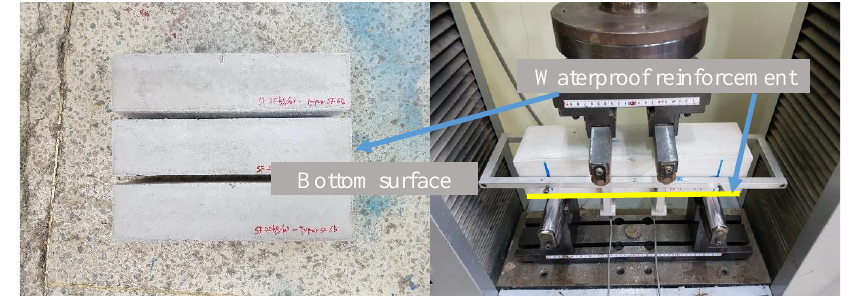
Figure 1. Flexural test setup with waterproof reinforcement.